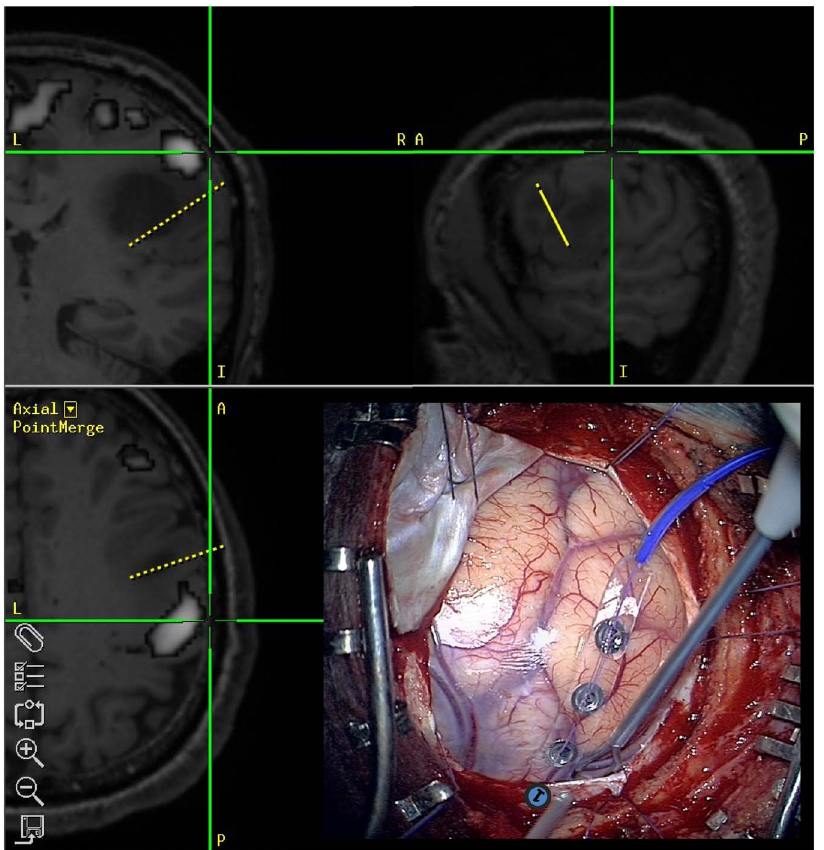
Figure 5. A representative case (Case 8) of intraoperative electro-cortical stimulation (ECS) mapping, performed through the use of a bipolar probe and a 4-contacts strip electrode (bottom right), with the support of neuronavigation system. Task-based fMRI map overlaid on T1-weighted MR images was loaded on the neuronavigation device (upper panel and bottom left). In this patient, ECS evoked mouth motion in the cortical site 1 (under the dura), as illustrated in intraoperative optic microscopic view (bottom right). With the aid of the neuronavigation device the position of each ECS site was determined on the presurgical fMRI dataset.